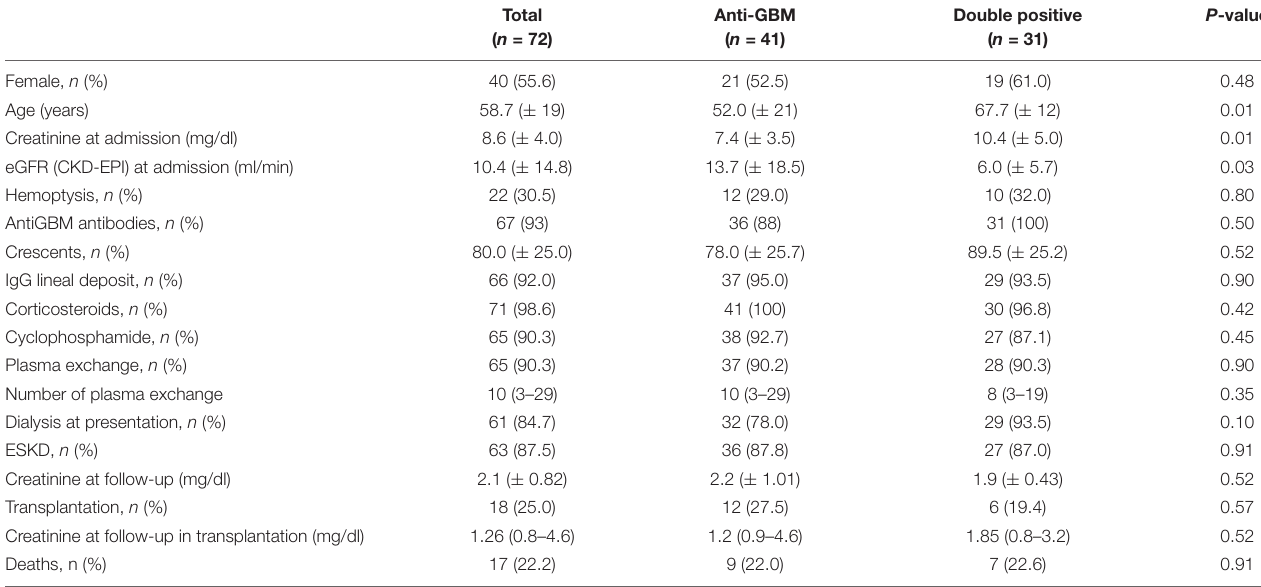
TABLE 1 | Demographic and analytical characteristics of the patients.